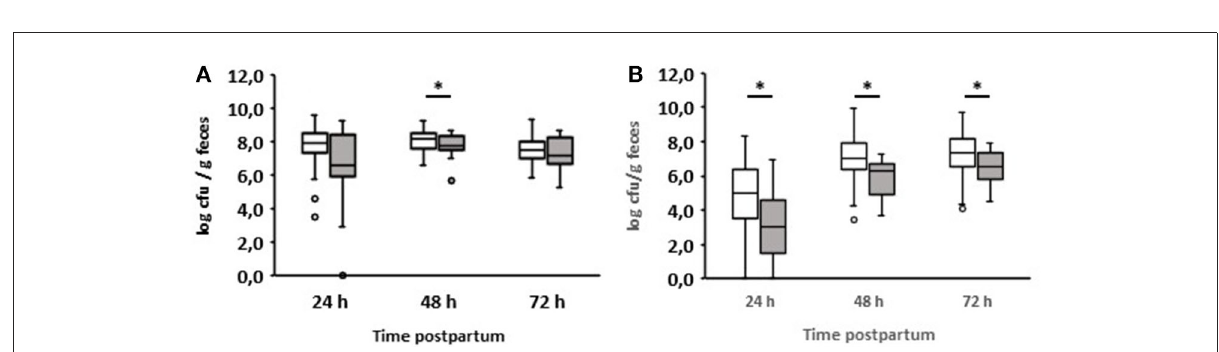
FIGURE6 Counts of enterococci (A) and lactobacilli (B) in feces of calves from farms where diarrhea occurred on day 2 of life. White boxes: feces of healthy calves ( n = 79). Gray boxes: feces of calves with diarrhea onset on day 2 of life ( n = 16; Wilcoxon test, * p < 0.05).